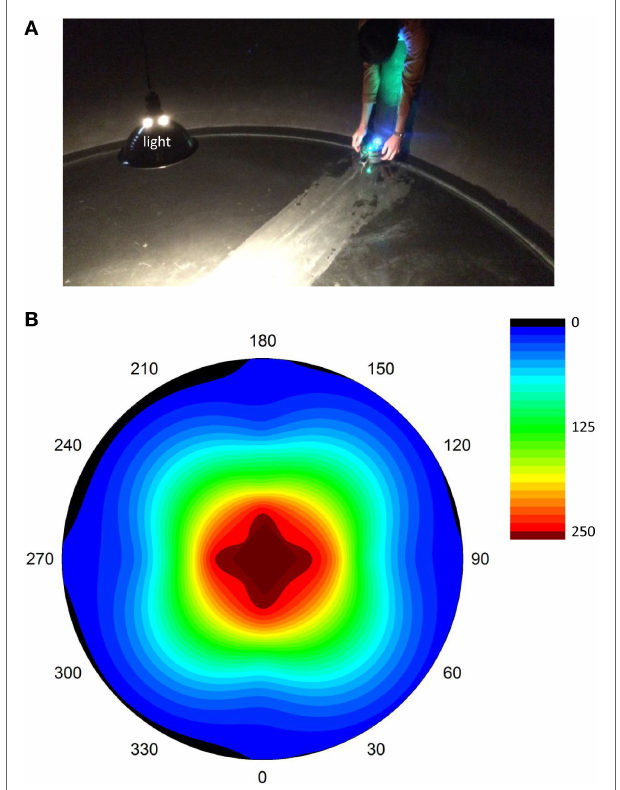
FigUre 3 | selection experiments . (a) Launch of Tadro in the “head out” starting position. A single light source is present, and reflections from the walls are reduced by the black matte finish of the tank, which is 3.05 m in diameter. Each trial lasted 5 min; each of the 10 individual ANNs were tested twice (starting position head-in and head-out) in random order within that generation. (B) Light gradients in the tank, as measured by the LDR “light mouth” on the top of the Tadro. Measurements were made by manually moving the Tadro along transects running on radii from 0° to 180° and 90° to 270°. Intermediate values were interpolated between measuring points on the radii and between radii, a process that distorted the isoclines from a circular shape expected with exhaustive spatial coverage. Cool colors are low light intensity; hot colors are high light intensity. The units are arbitrary, scaled to account for the input range of the LDRs.